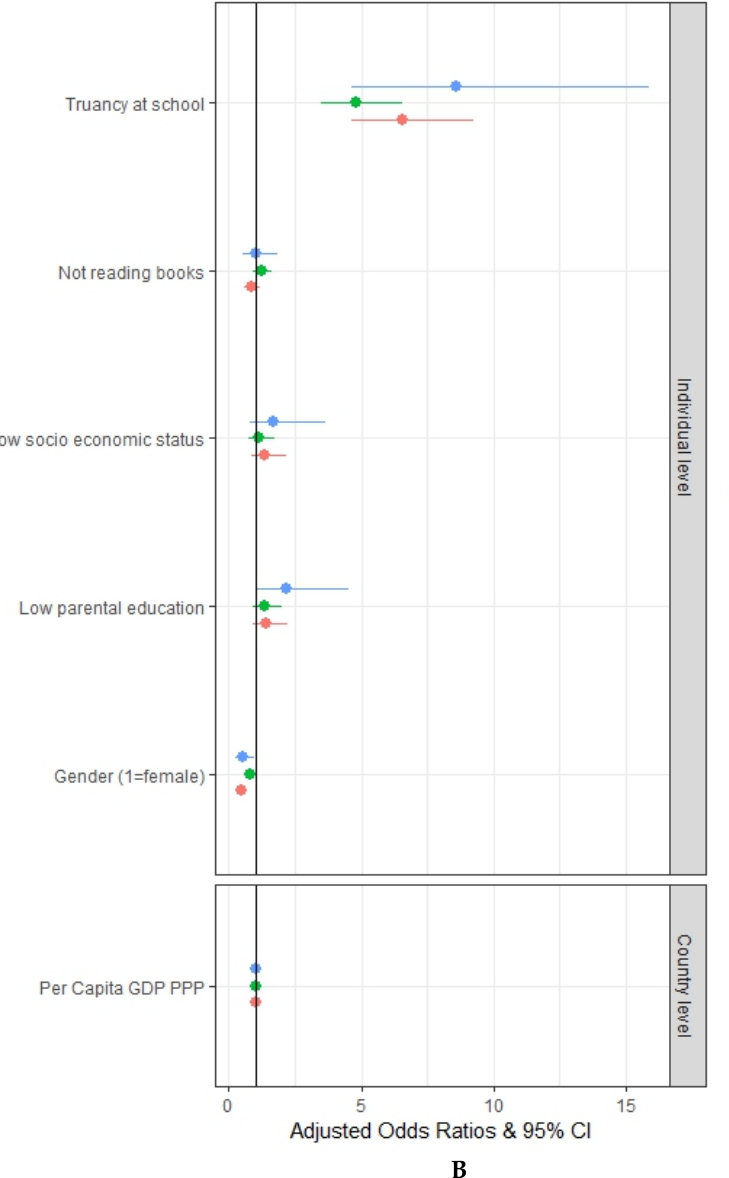
Figure 3. Multivariate multilevel mixed-effects logistic regression adjusted odds ratios with a 95% confidence interval: (A) relation between students’ socioeconomic status, parental education and the patterns of heroin use (Experimenter, Episodic and Frequent); (B) relation between students’ socioeconomic status, parental education, truancy at school, reading books for enjoyment and the patterns of heroin use (Experimenter, Episodic and Frequent). Authors’ elaboration on ESPAD data.